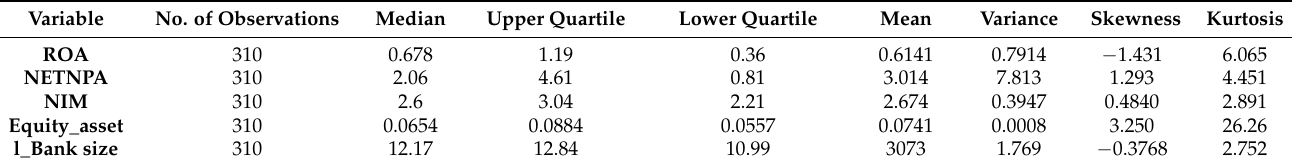
Table 3. Univariant Statistics of the